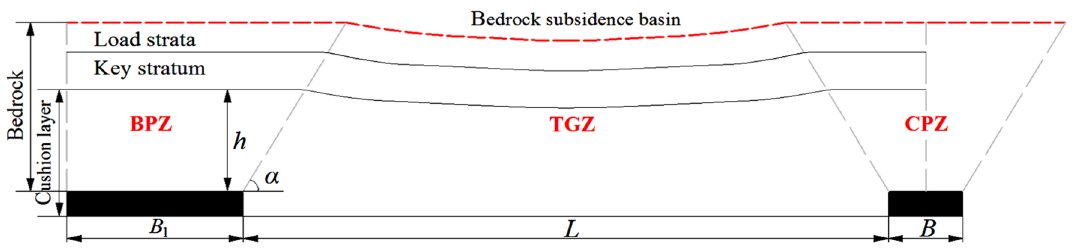
Figure 7. Subsidence prediction model in dip